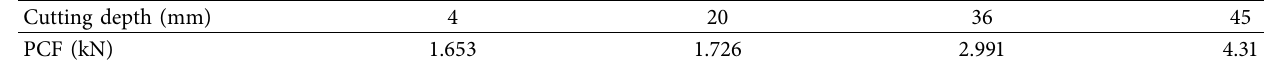
Table 7: The PCF with different cutting depth.